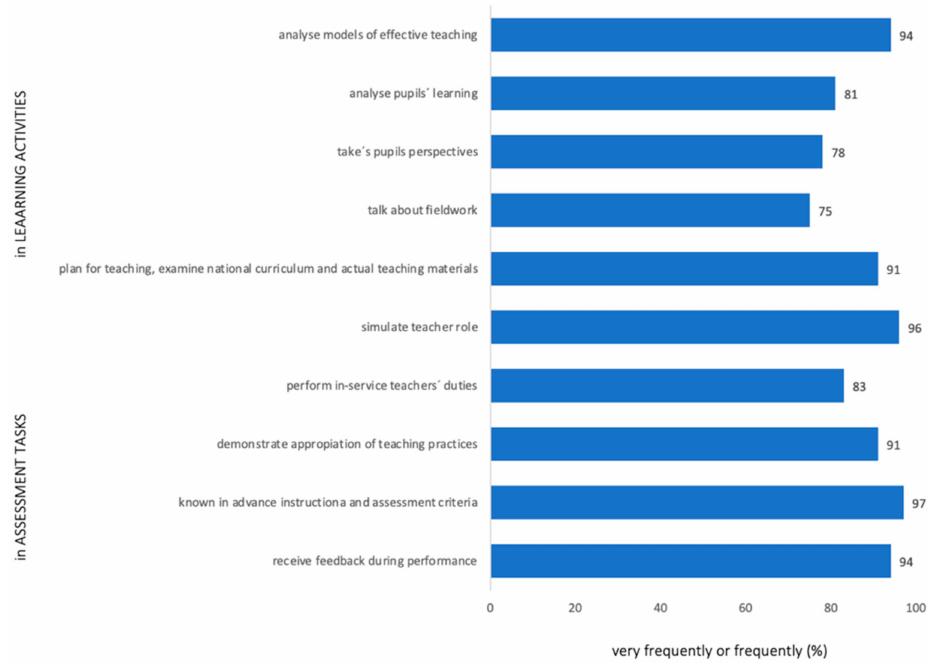
Figure 1. Practices opportunities recognized by pre-service teachers.